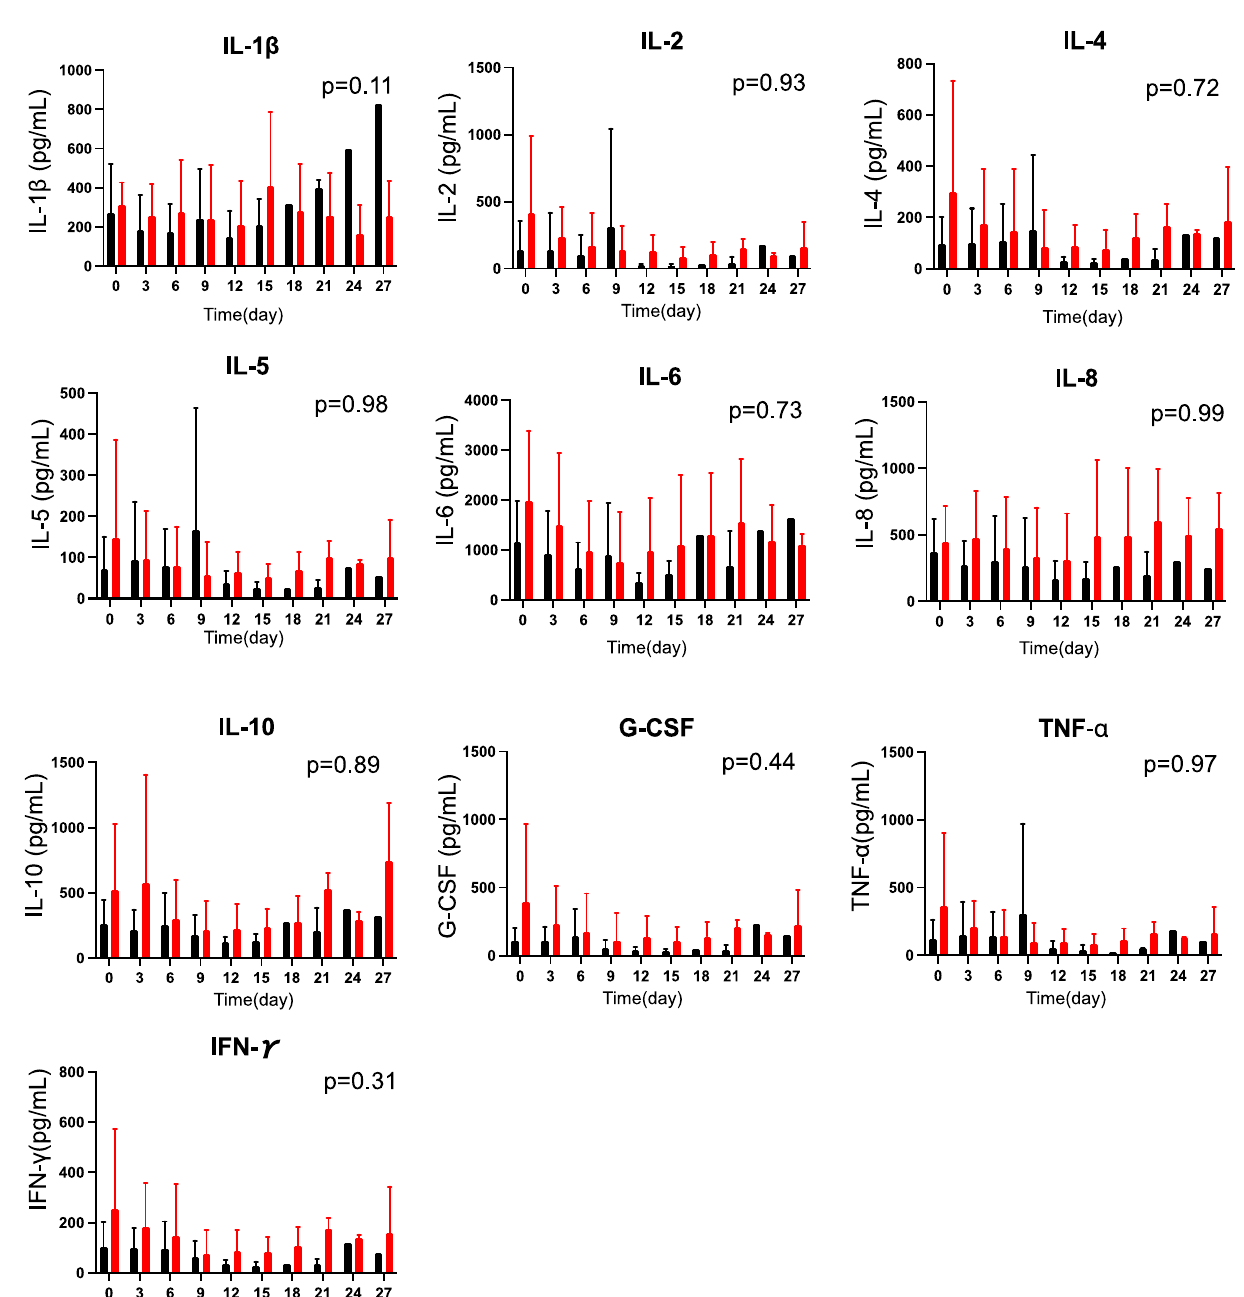
Figure 5. Effects of CoQ10 supplementation on plasma cytokine concentrations in burn patients. and IFN- γ between the groups. The p values in the figures indicate overall differences between the groups across the different time points that were analyzed using a longitudinal general linear mixed-effects model. Black bar: Placebo, Red bar: